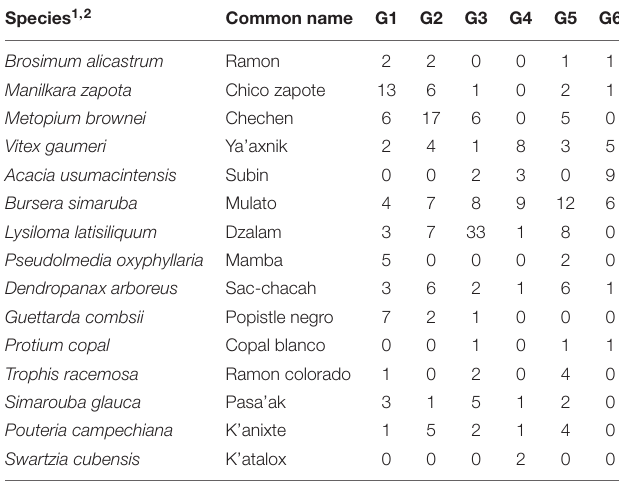
1 Tree taxa were chosen as representative based on the top 15 most consumed tree species by black howler monkeys inhabiting a relatively continuous forest (Righini, 2014; Righini et al., 2017). 2 Frequency of feeding tree taxa was recorded in 1000 m 2 for each howler home range.